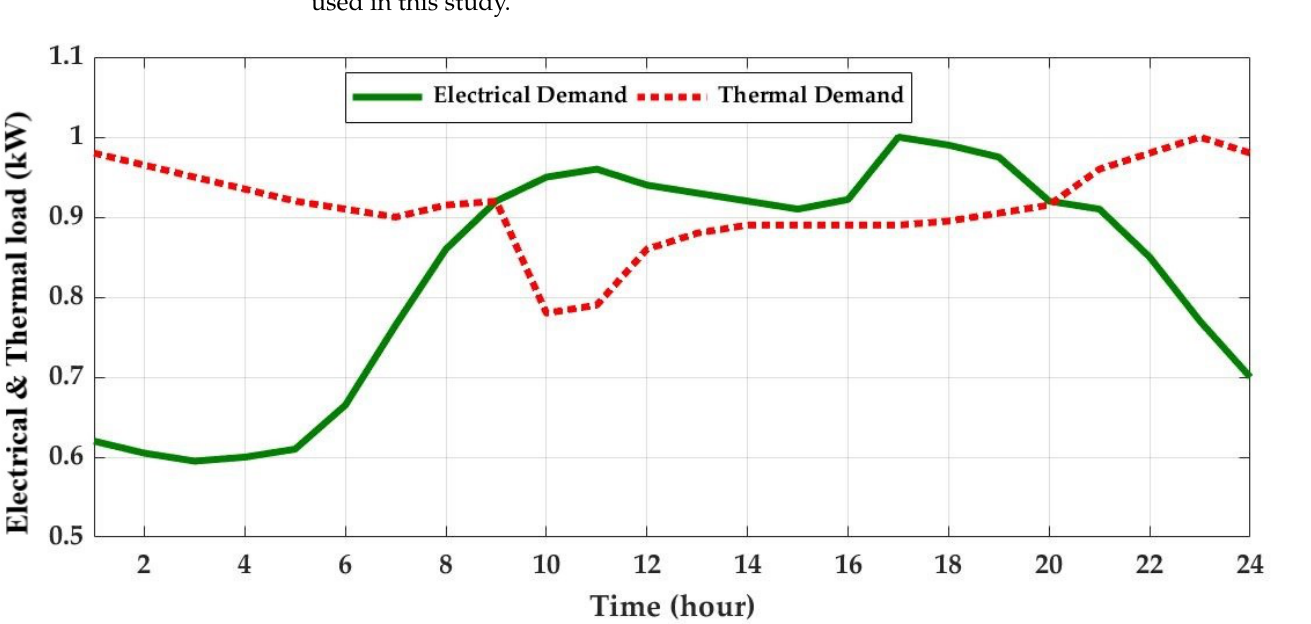
Figure 9. Daily electrical and thermal load requirements of a smart